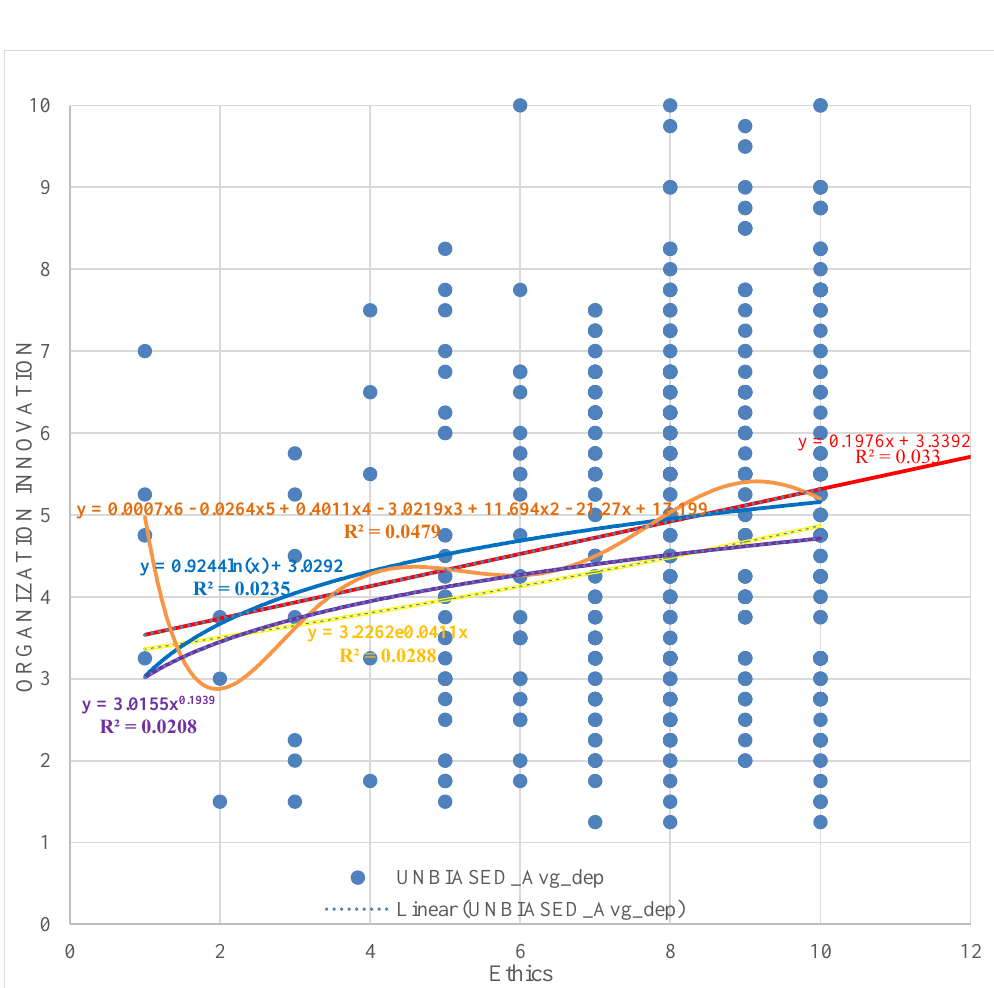
Fig. 4. Regression functions adjusted to the data cloud. Source: authors’